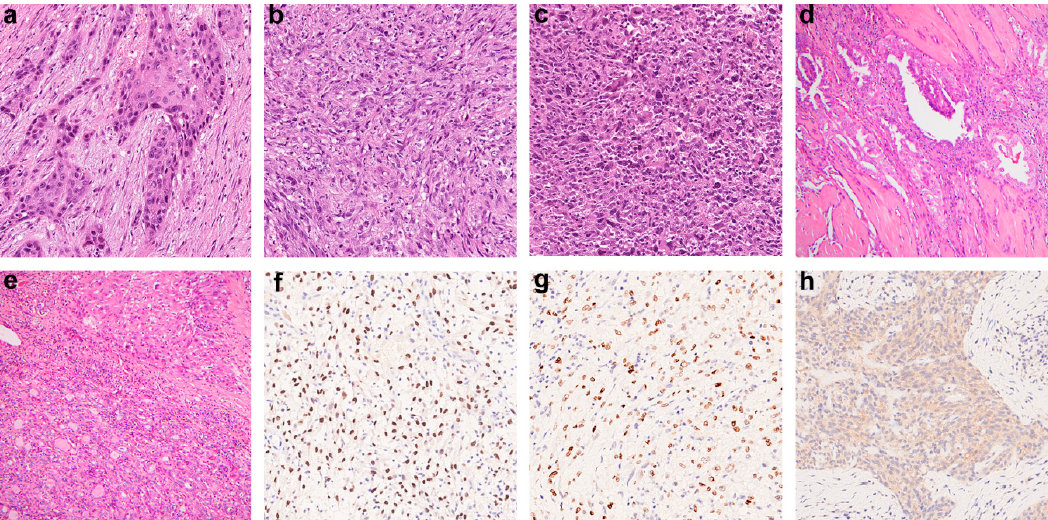
Figure 1. Anaplastic thyroid carcinoma. Common morphologic patterns include epithelial ( a ), sarcomatoid ( b ), and giant cell ( c ) pattern (H&E, 200 × ). Papillary carcinoma ( d ) and follicular carcinoma ( e ) coexist with the anaplastic component in an intermingled arrangement or with a sharp border (H&E, 100 × ). Cases positive for PAX8 ( f ), TTF-1 ( g ), and BRAF VE1 ( h ) immunostains are shown (200 ×